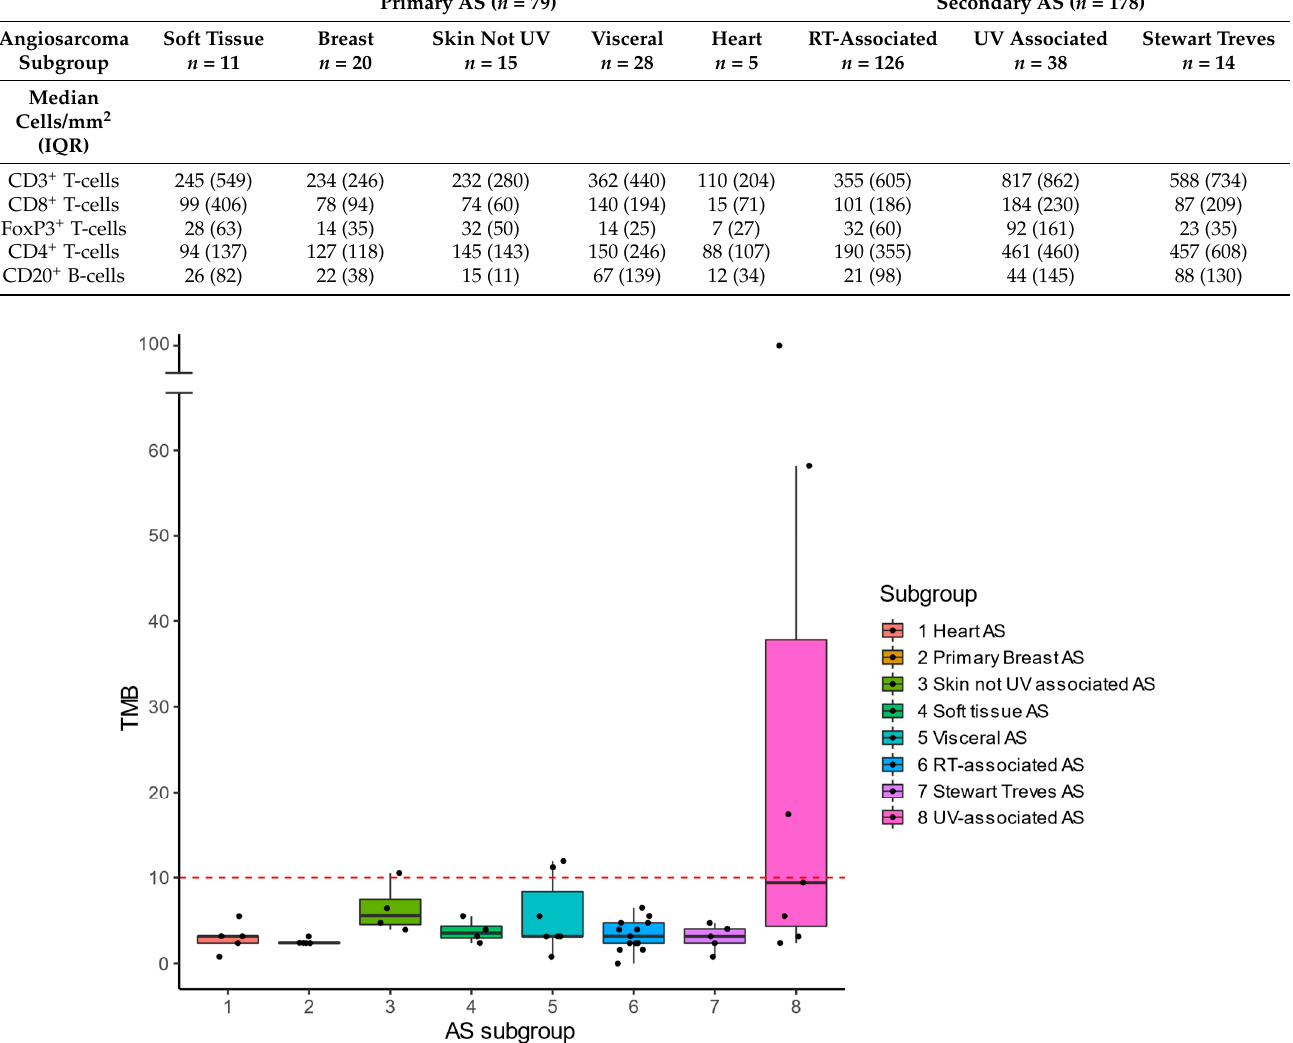
Figure 3. Genomic and immunological landscape of 50 angiosarcoma tumor samples. (Likely) Path- ogenic mutations and gene amplifications detected in ≥ 2 tumors are reflected in this figure. Cell densities for CD3 + , CD8 + , FoxP3 + , CD4 + T cells and CD20 + B cells are reflected based on the number of cells/mm 2 .